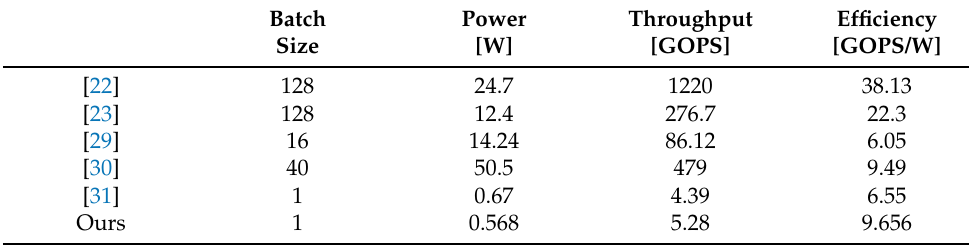
Table 1. Comparison to state-of-the-art FPGA training frameworks. Batch Size